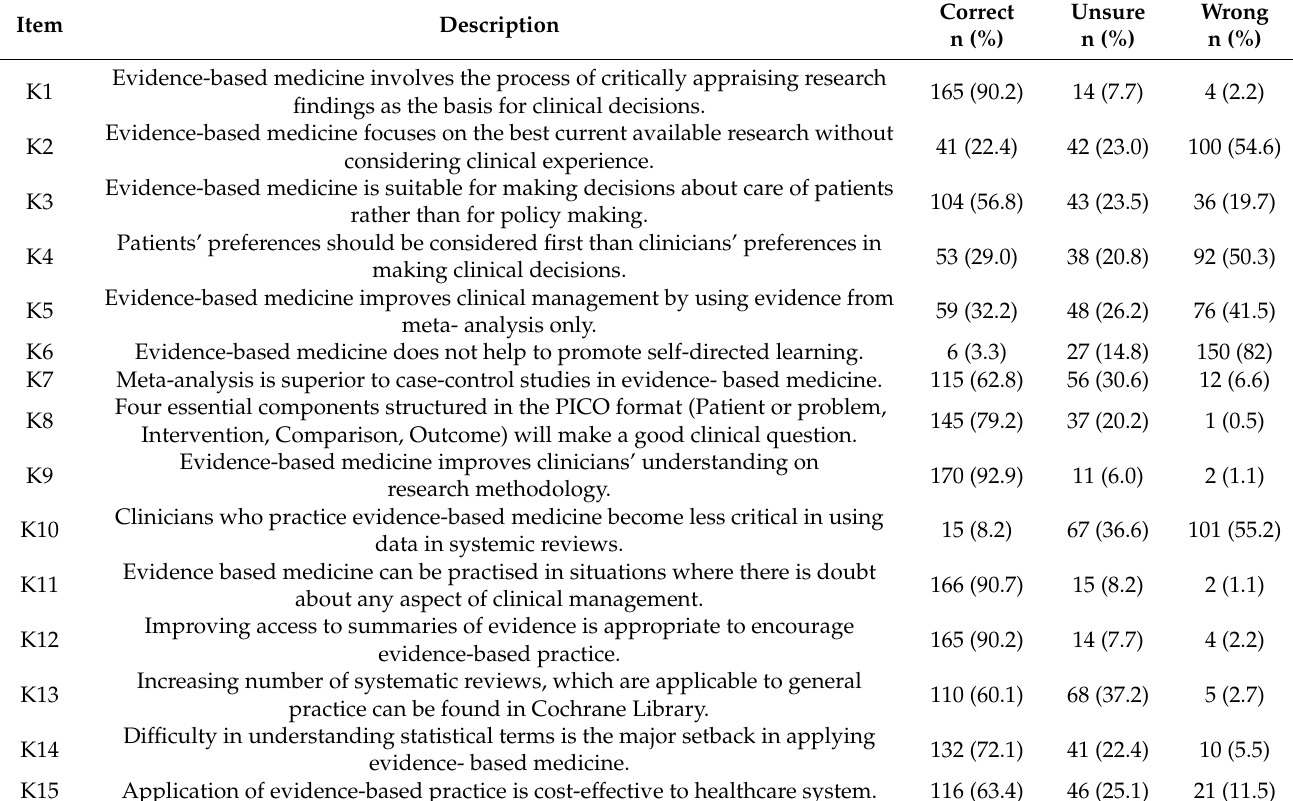
Table A1. Responses to Knowledge on Evidence-Based